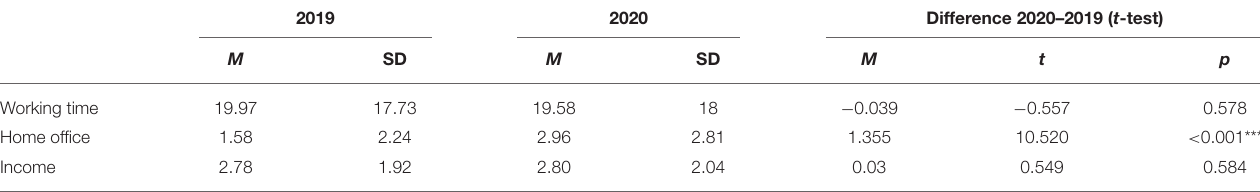
TABLE 5 | Employment situation in 2019 and 2020 ( n =